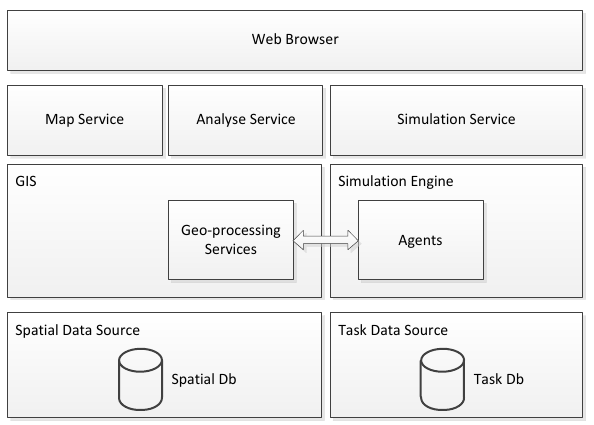
Figure 1. Framework